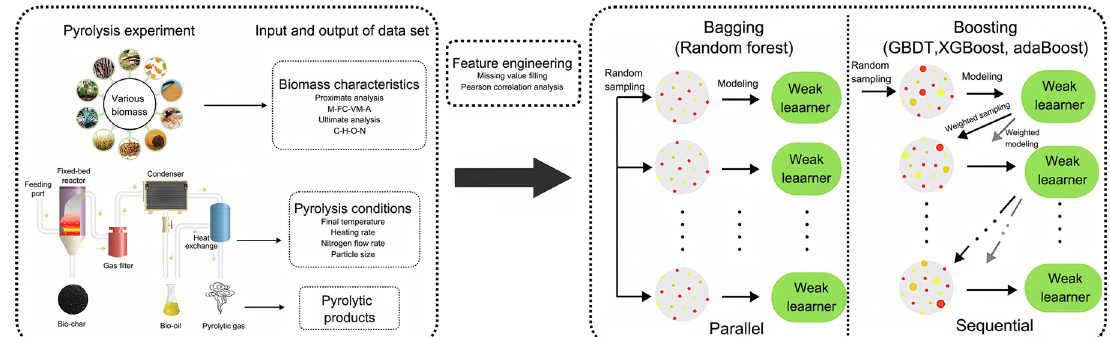
Fig. 4 A specific case of machine learning used to understand the pyrolysis process of biochar (Reproduced with permission from ref Dong et al. 2022). Copyright Elsevier